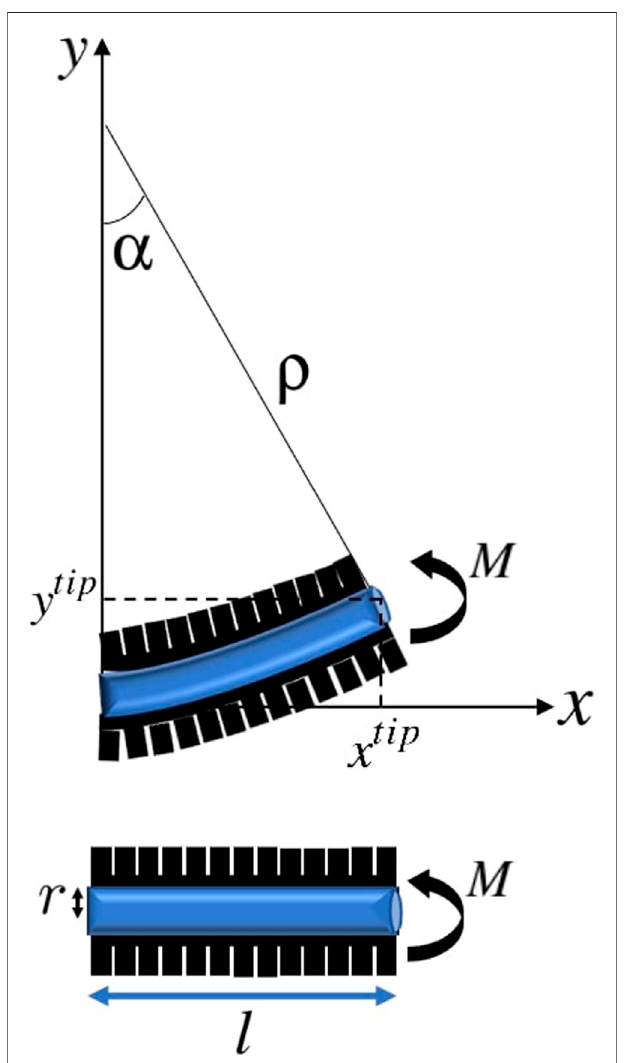
FIGURE 2 | Actuated soft catheter and its de fl ection under the moment corresponding to the pneumatic actuator, resulting in a circular con fi guration with the constant radius ρ and bending angle α .